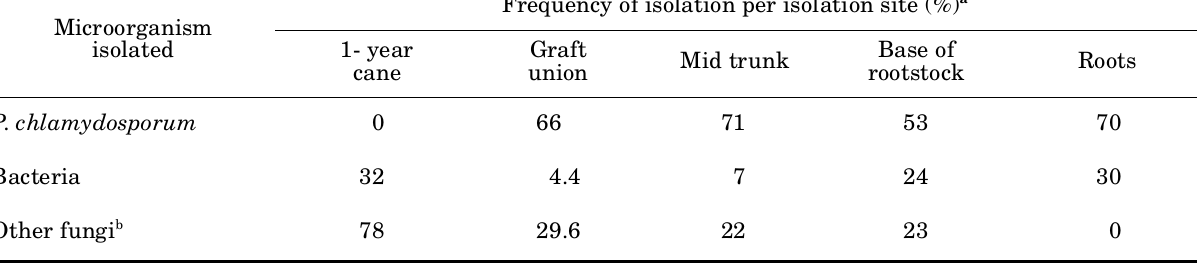
Table I. Isolation of Phaeoacremonium chlamydosporum carried out on various sites of 10 plants from decline of young grapevines (Victoria/775 Paulsen) observed in Sicily.